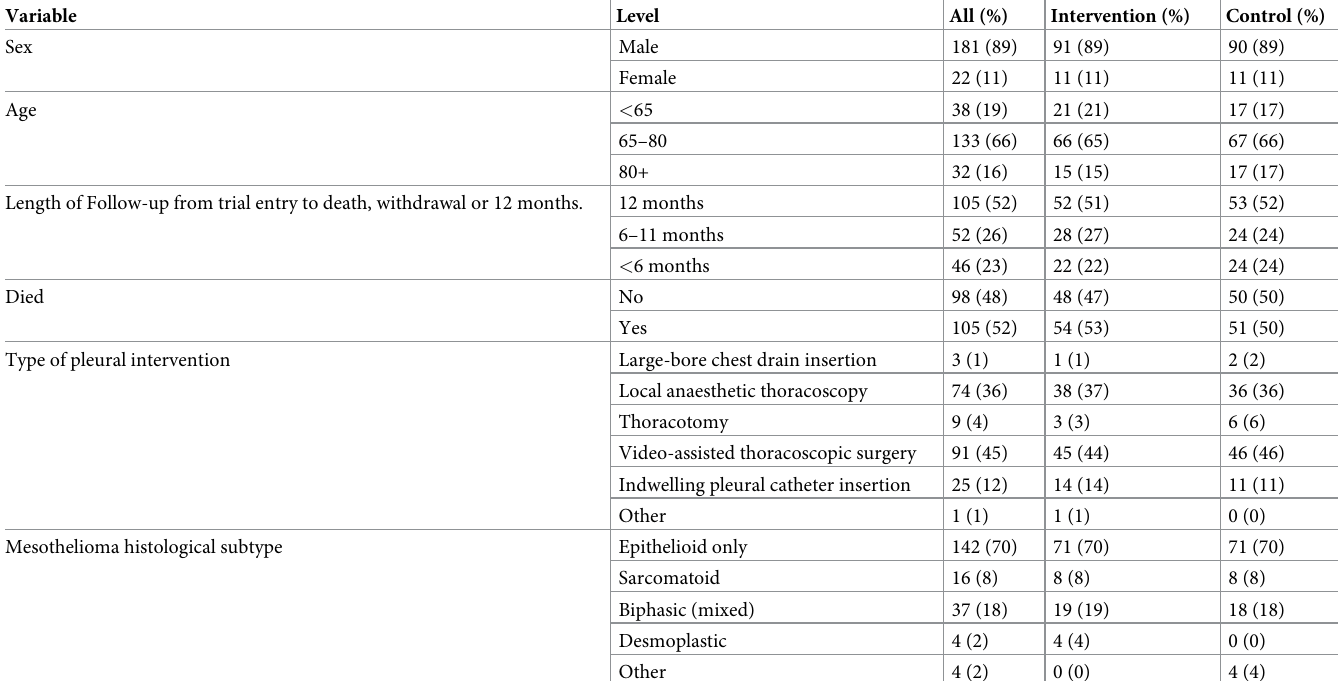
Table 2. Patient demographics, disease and treatment information, overall and by intervention group.